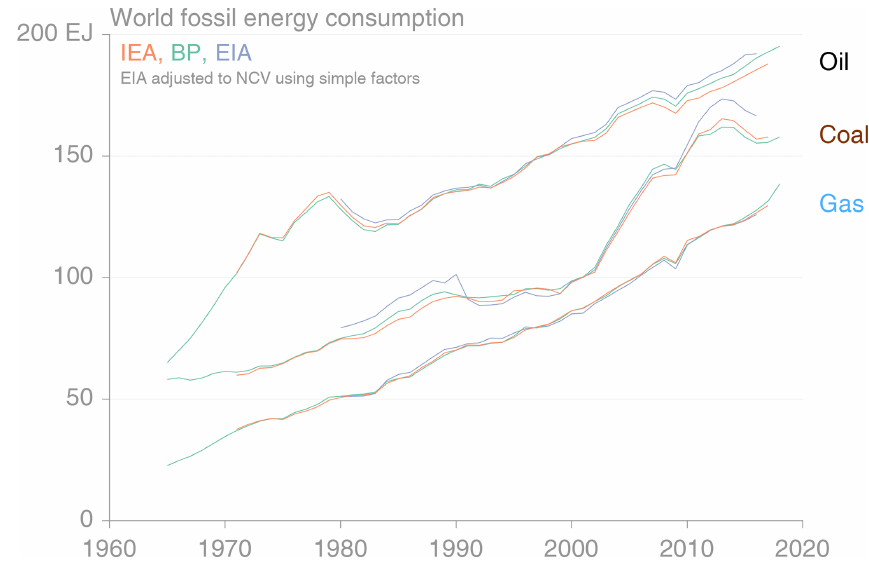
Figure 6. Global energy consumption estimates from three sources. The EIA reports energy production in gross calorific value (GCV), and this has been converted to net calorific value (NCV) using the standard factors of 0.9 for natural gas and 0.95 for oil and coal.